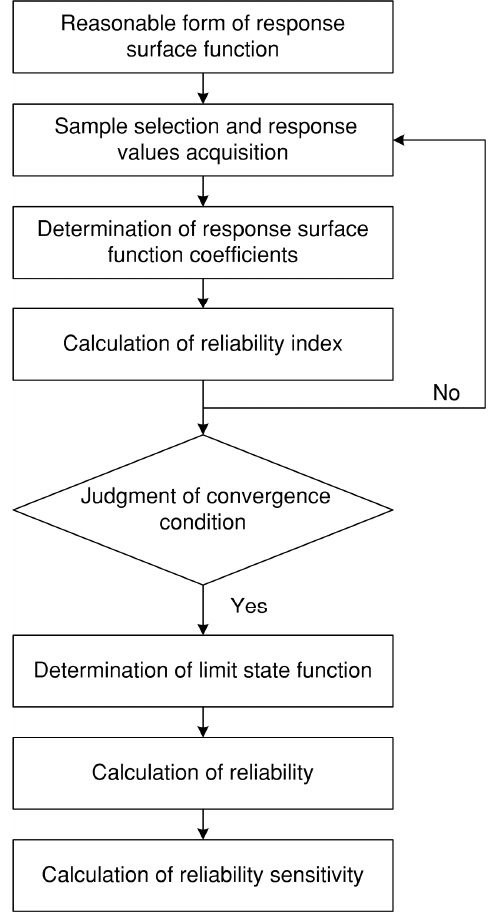
Figure 8. Flowchart for the model.